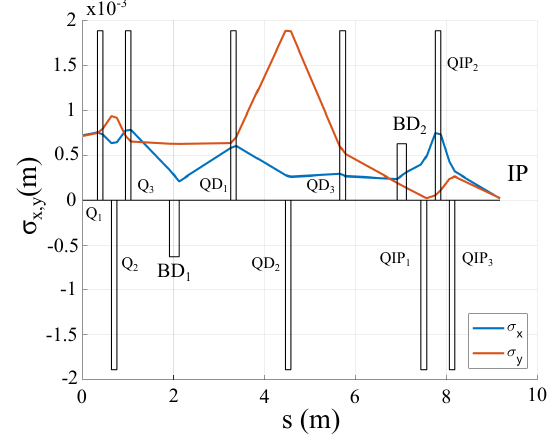
Figure 6. Transverse rms size σ x (mm) (in blue) and σ y (mm) (in red) as a function of the distance s from the Linac